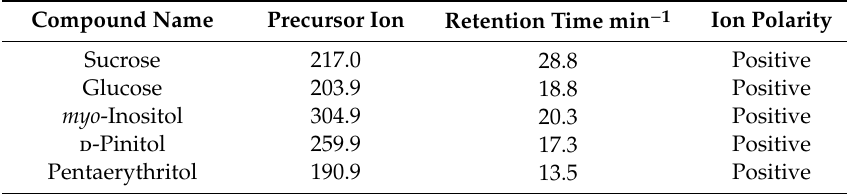
Table 1. Information used to identify target compounds for metabolite